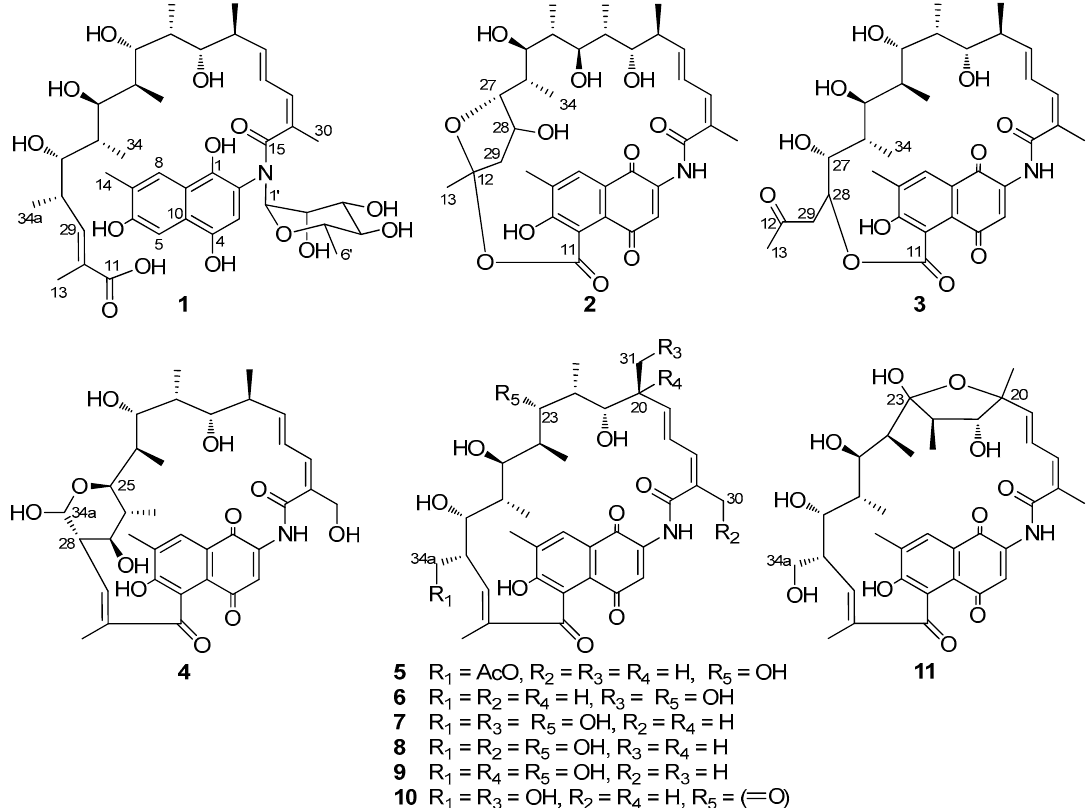
Figure 1. Structures of new compounds 1 – 11.